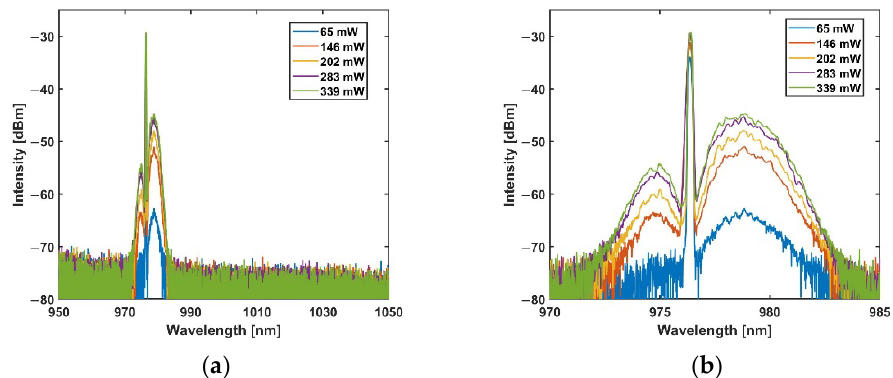
Figure 2. The variation of spectra with pump power. ( b ) The zoom-in spectra of ( a ). The seed power is 41 mW.